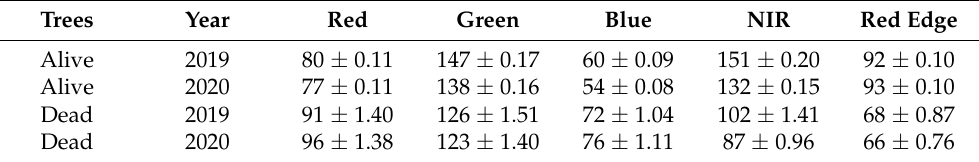
Table 3. Mean band values and standard error of the mean for trees that survived and died, by year. Alive or dead refers to the trees’ health in 2020. Trees that were already dead in 2019 were excluded. Trees Year Red Green Blue NIR Red Edge Alive 2019 80 ± 0.11 147 ± 0.17 60 ± 0.09 92 ± 0.10